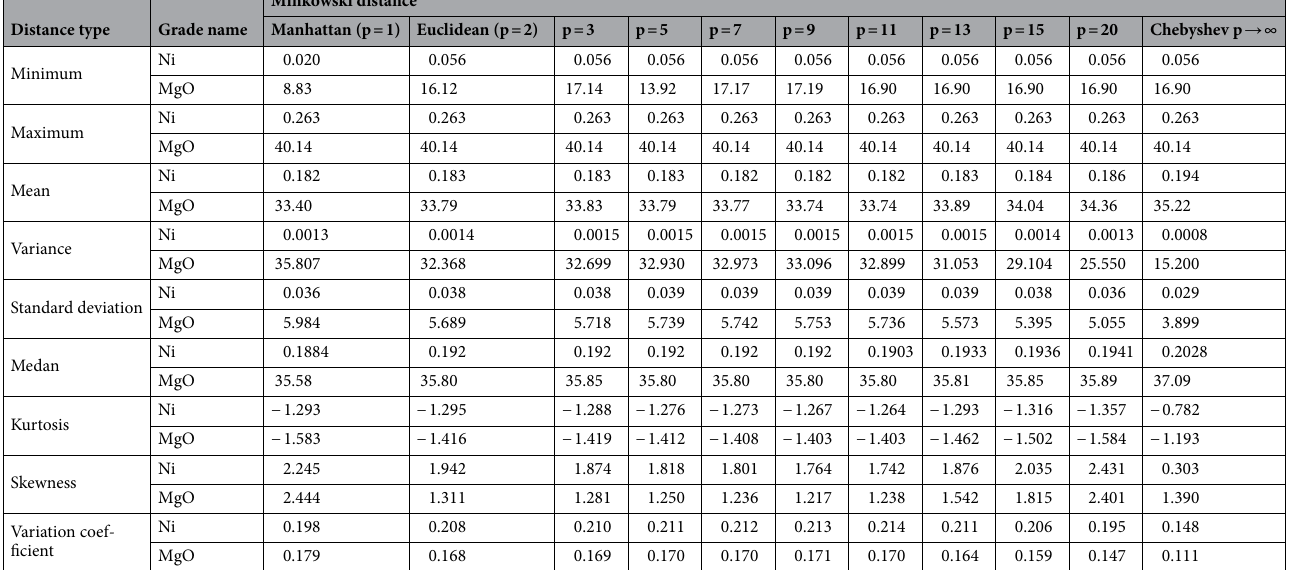
Table 1. Estimation grade statistics of model 1.